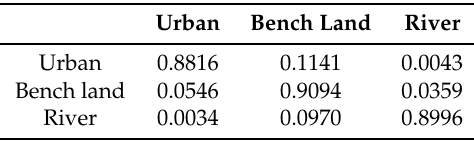
Table 13. Confusion matrix of labeled pixels obtained by classification network based on the proposed MAE.